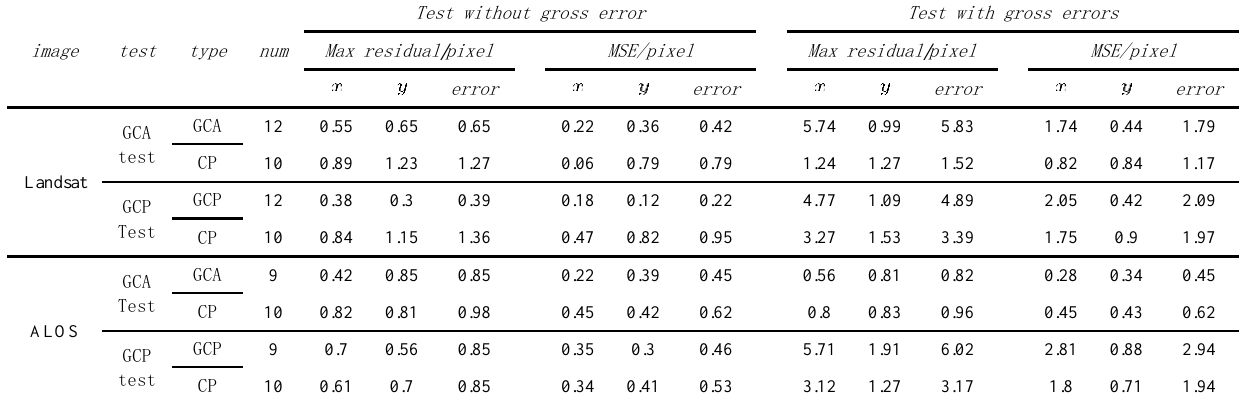
Table 1 Comparison of experimental